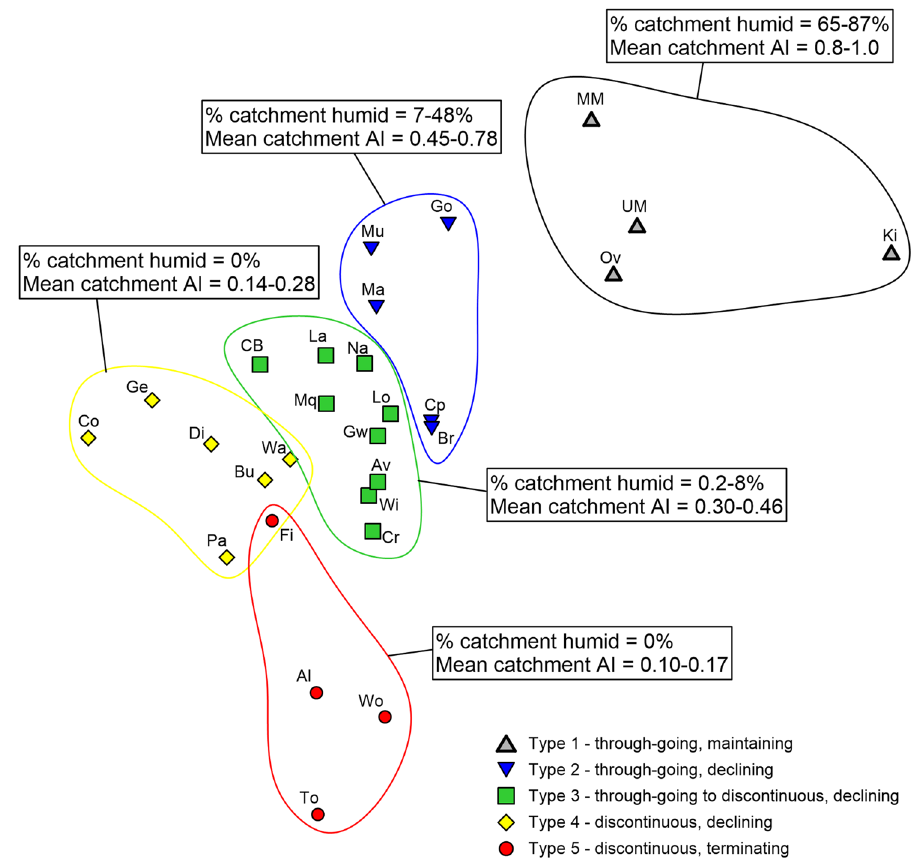
Figure 4. Non-parametric multidimensional scaling (nMDS) resemblance matrix visualising the level of similarity between each river type based on key geomorphological and hydroclimatic variables (see Methods; Table 2). Pairwise ANOSIM analysis shows that each river type is statistically different from one another ( p < 0.05; see Table 2 and Supplementary Table S1). Each point on the nMDS plot represents a different river and points closer together are more similar to one another based on the measured variables, and points further apart are more dissimilar. Annotations summarise the percentage of catchment area classed as humid for each river type, and the envelopes of mean catchment AI values for each river type. See Fig. 1 for catchment labelling conventions and Table 3 for a list of all